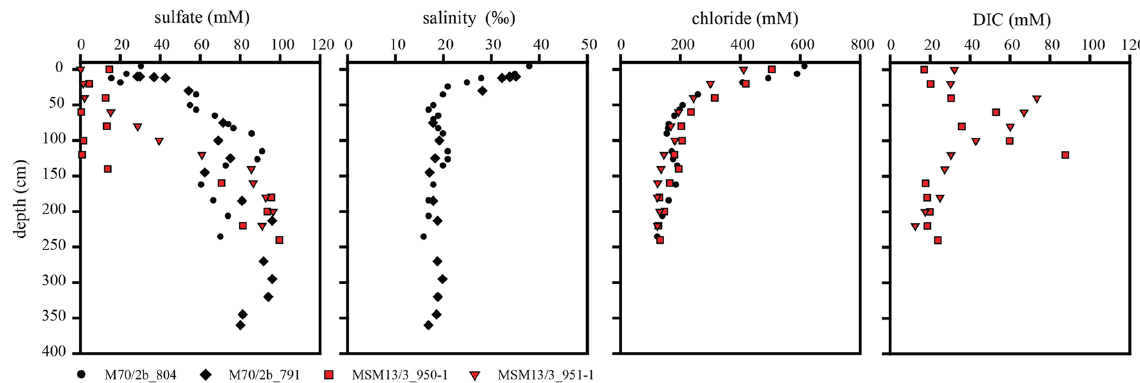
Fig. 4. Sulfate, chloride concentrations, and salinity from deeper coring of the central dome of the Amon MV. Years 2006 and 2009 are indicated by black and red symbols,